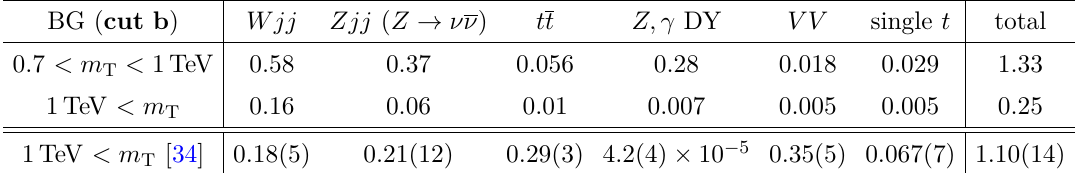
Table 2 . Expected number of SM background events after cut b (the τ ± ν + b search) for R L dt = √ s = 13 TeV in each background category. The last row shows the result by ref. [34], 35 . 9 fb − 1 and where a number in the parenthesis represents uncertainties. Note that their b -tagging efficiencies are different from ours (see the footnote 3). Detailed cut flows are shown in table